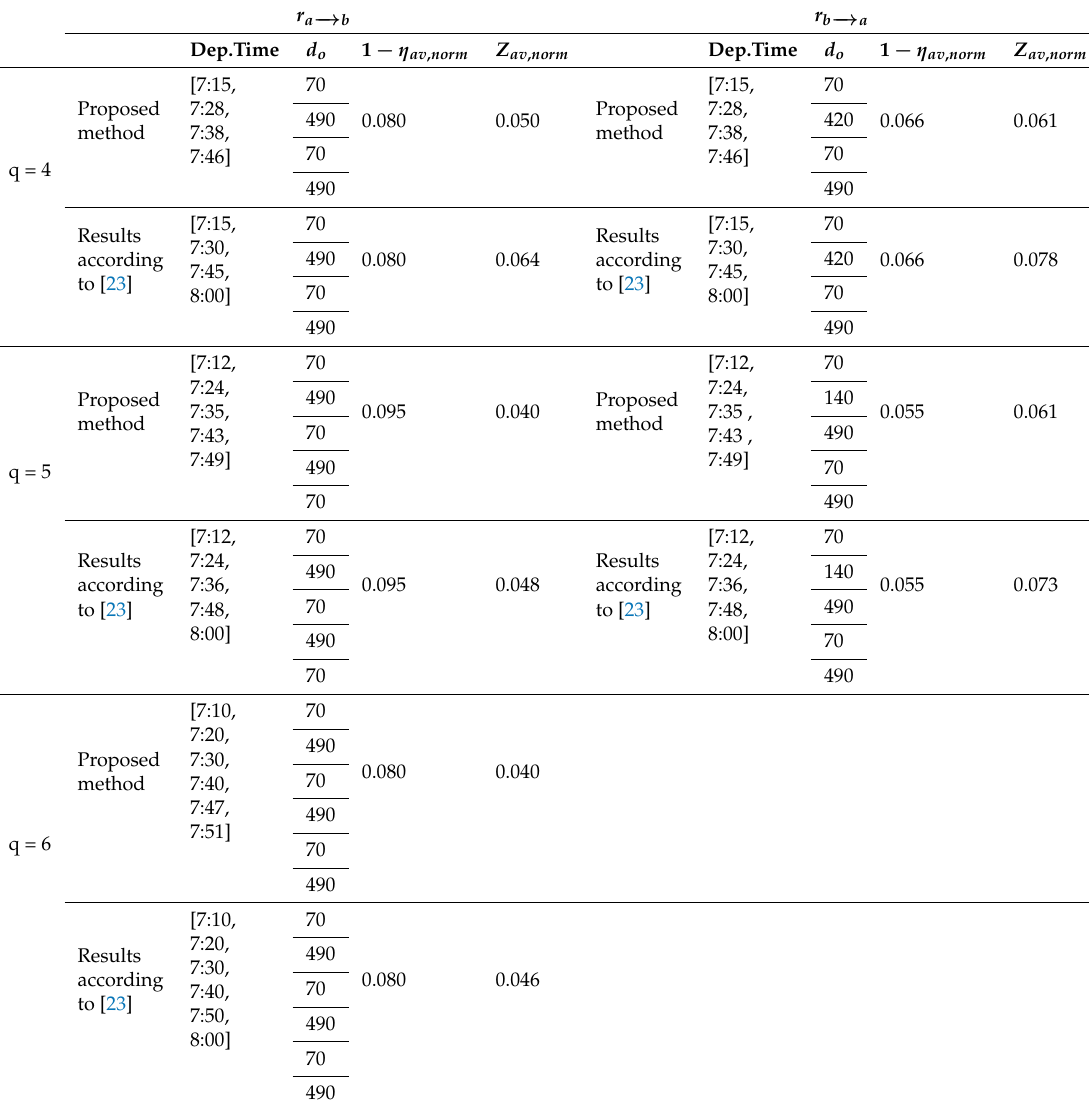
Table 6. Results obtained when vehicle occupancies of Experiment 2 are combined with corresponding departure times of Experiment